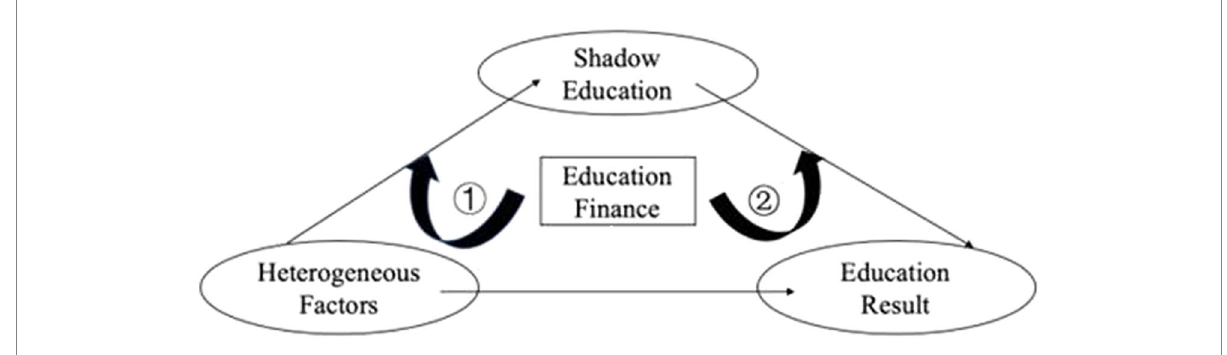
FIGURE 3 The moderation path of education